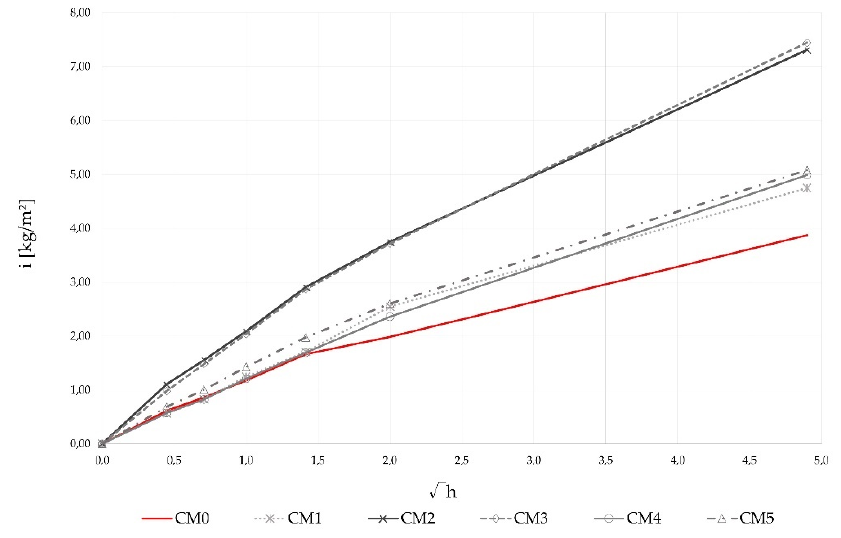
Figure 8. Average water uptake per unit area (i) against square root of the time immersion of concrete samples.